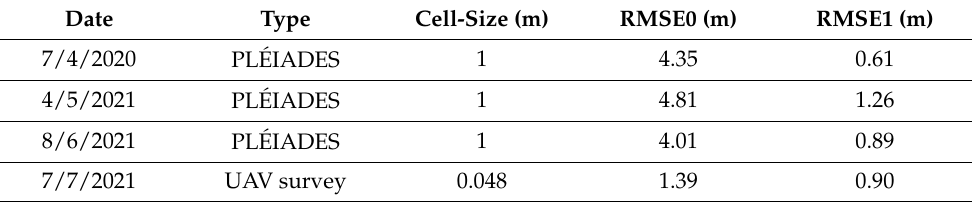
Table 4. Results of the PL É IADES and UAV survey DEM adjustments, with respect to the 2012 LIDAR DEM. RMSE0 and RMSE1 are root mean square errors computed between the 2020–2021 DEMS and the 2012 DEM before and after the co-registering procedure, respectively.